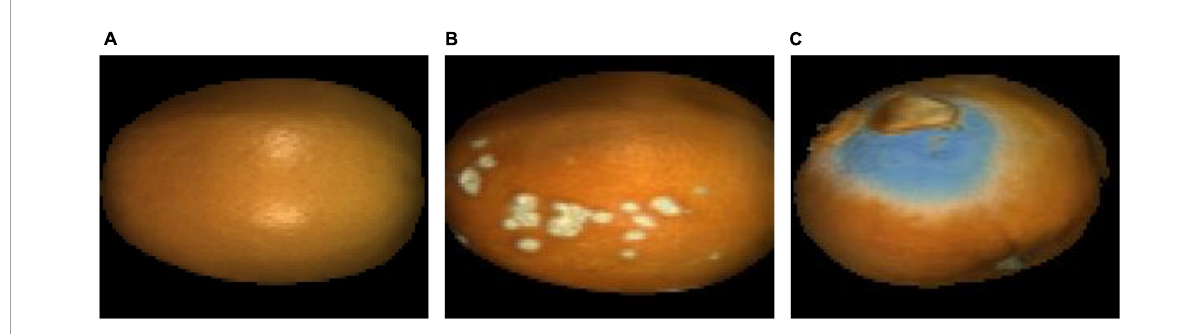
FIGURE5 False-color images after spherical correction. (A) Navel orange sample with an intact surface; (B) navel orange sample with cankers; (C) navel orange sample with penicilliosis.